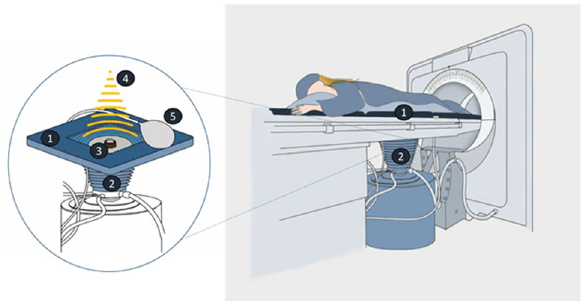
Figure 1. US-guided HIFU system: schematic illustration of the US-guided HIFU unit JC Tumor Therapeutic System (HAIFU Medical Technology, Chongqing, China). The treatment table has an aperture (1) with a water basin (2). Patients with uterine fibroids lie in prone position with their lower abdominal wall at the level of the aperture, so that the skin gets into contact with cooled water. The parabolic therapeutic transducer (3) and the convex diagnostic ultrasonography probe are located in the center of the water basin. A therapeutic ultrasound beam (4) is transmitted to the lesion. A ceramic transducer with a diameter of 15 cm and a focal length of 15 cm is used for this at a frequency of 0.8 MHz. Between the transducer and skin of the lower anterior abdominal wall a balloon filled with degassed water (5) is positioned to keep the bowel away from the acoustic pathway. The ultrasound beam generated during the HIFU procedure has an oval-shaped focus of 1-3 mm in width and 8-15 mm in length. In this approach, a coagulation necrosis lesion is created in the target area. The next focal point is selected when grey-scale changes become apparent in the target area indicating effective ablation. Thus, multiple adjacent lesions on bordering layers produce linear and discoidal necrosis patches, allowing the entire tumor area to be ablated as a volume unit.